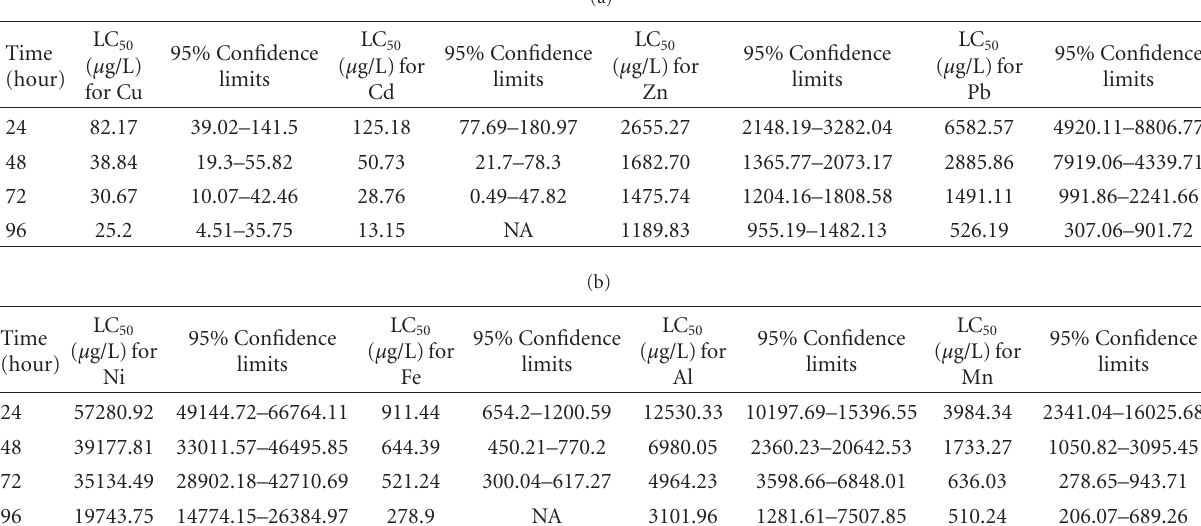
Table 2: Median lethal concentrations (LC 50 ) for S. major at di ff erent exposure times for Cu, Cd, Zn, Pb, Ni, Fe, Al, and